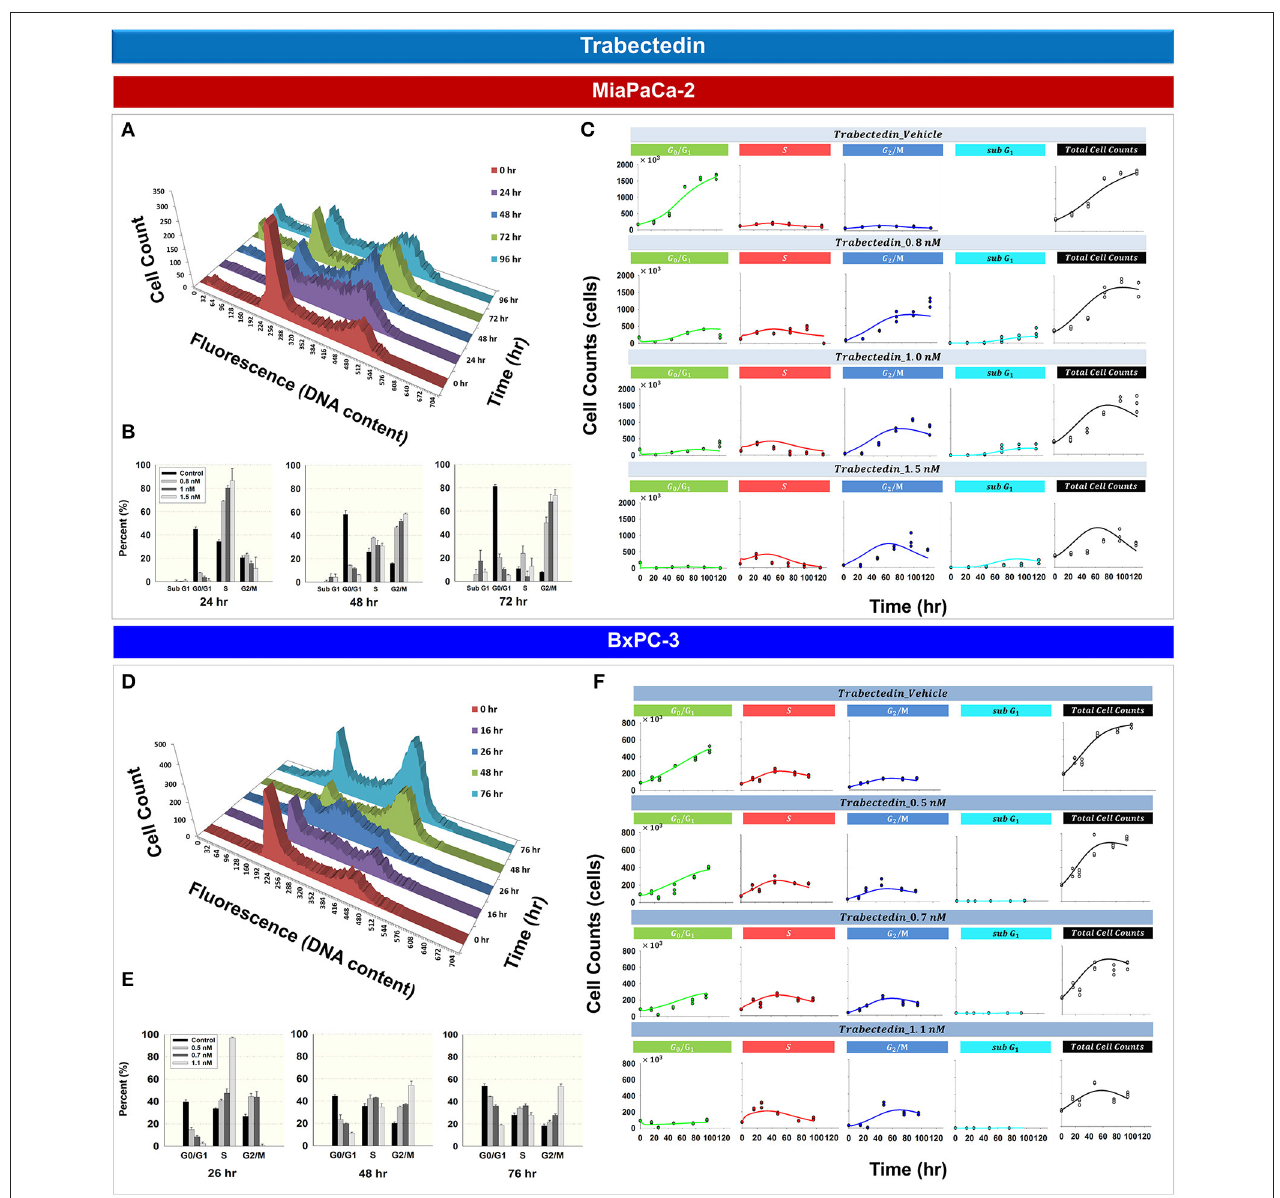
FIGURE 4 | Trabectedin effects on the cell cycle for MiaPaCa-2 and BxPC-3 cells. (A,D) histograms showing temporal changes in cellular DNA content after continuous exposure of cells to 0.8 nM (MiaPaCa-2) or 1.1 nM (BxPC-3) trabectedin. All data are in triplicate. ( B,E) Fraction of cells in sub G 1 , G 0 / G 1 , S , and G 2 / M phase after incubating cells in the concentrations of trabectedin shown for 24, 48, and 72 h (MiaPaCa-2) or 26, 48, and 76 h (BxPC-3). Columns , mean of triplicate determinations; bars , SD. (C,F) Temporal change in number of cells in G 0 / G 1 , S , G 2 / M , sub G 1 phase, as well as total cell numbers, after incubating cells with concentrations of trabectedin shown for up to 120 (MiaPaCa-2) and 96 h (BxPC-3). Symbols represent observed data and lines represent fitted curves generated from PD model shown in Figure 1E